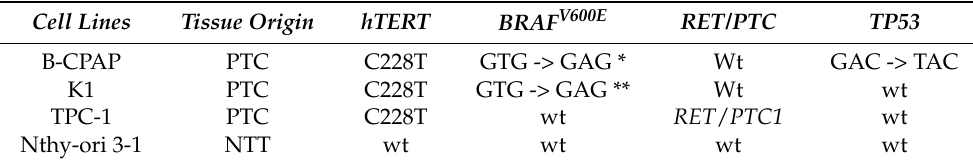
Table 1. Mutational status of cell